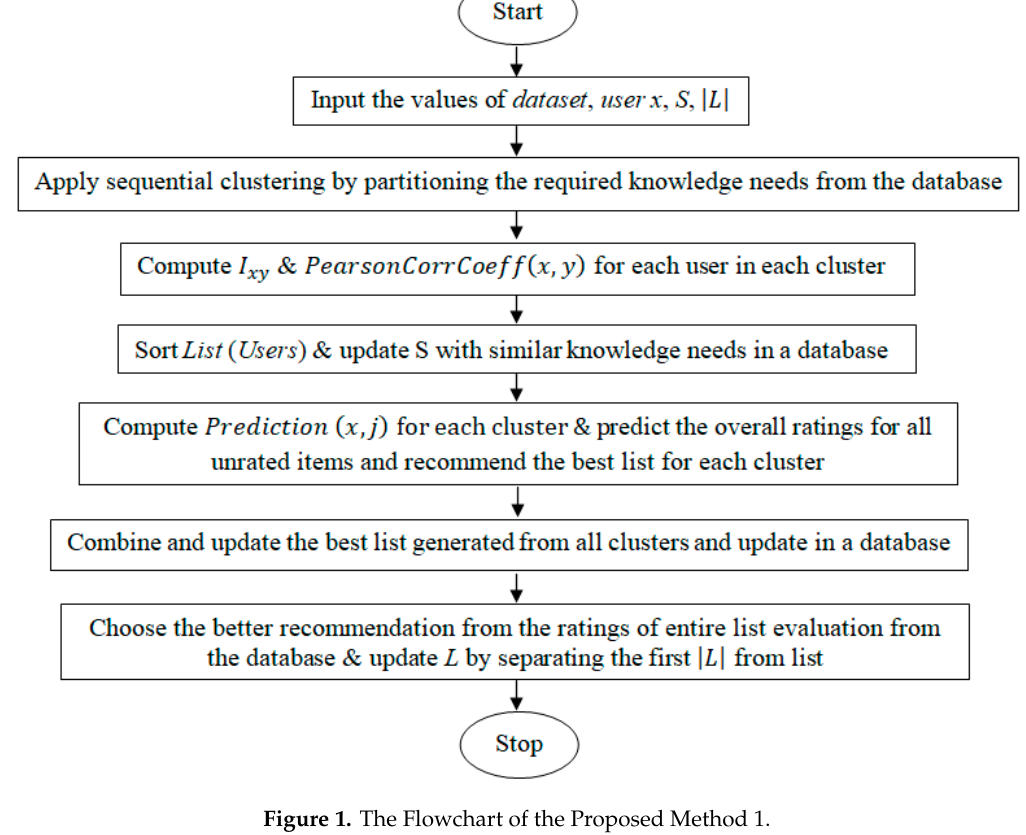
Figure 1. The Flowchart of the Proposed Method